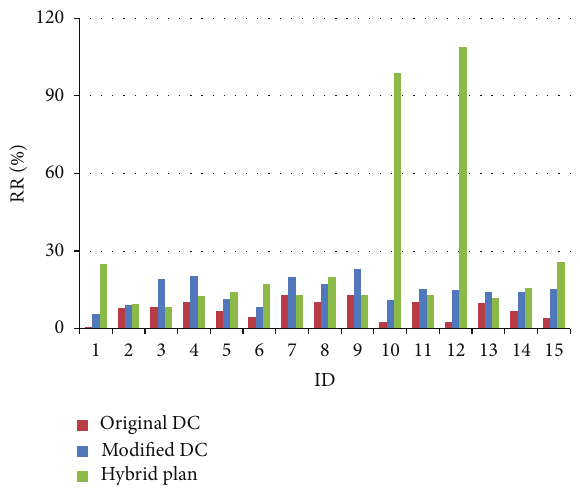
Figure 2: The replacement ratios of three defined contribution pension plans. Resource: spreadsheet model calculation results.